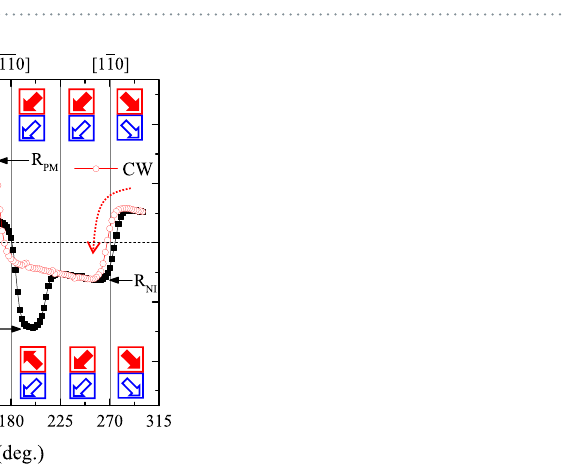
Figure 4. Magnetic free energy diagrams of the two GaMnAs layers with negative and positive ∆ R, drawn with blue and red lines, respectively.